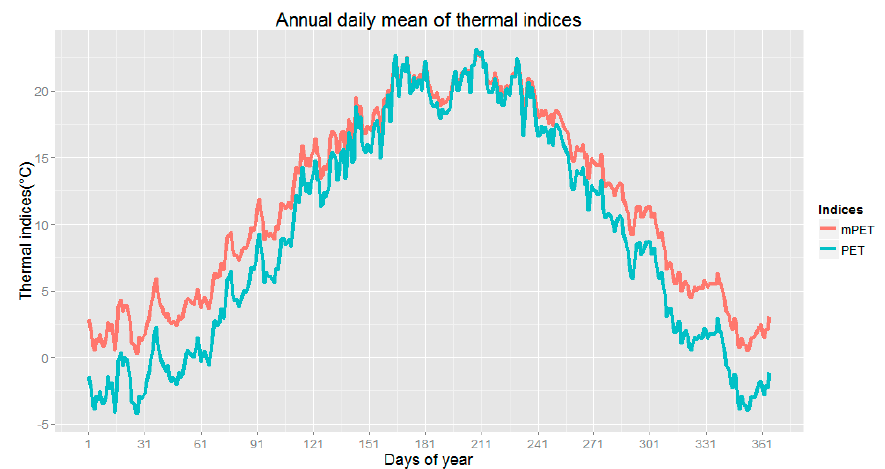
Figure 1. Range of exposure for physiologically equivalent temperature (PET) and modified PET (mPET) in positive and negative conditions of thermal component (illustration depicts only the effect range on negative and positive). Data source: mean daily data for Freiburg.